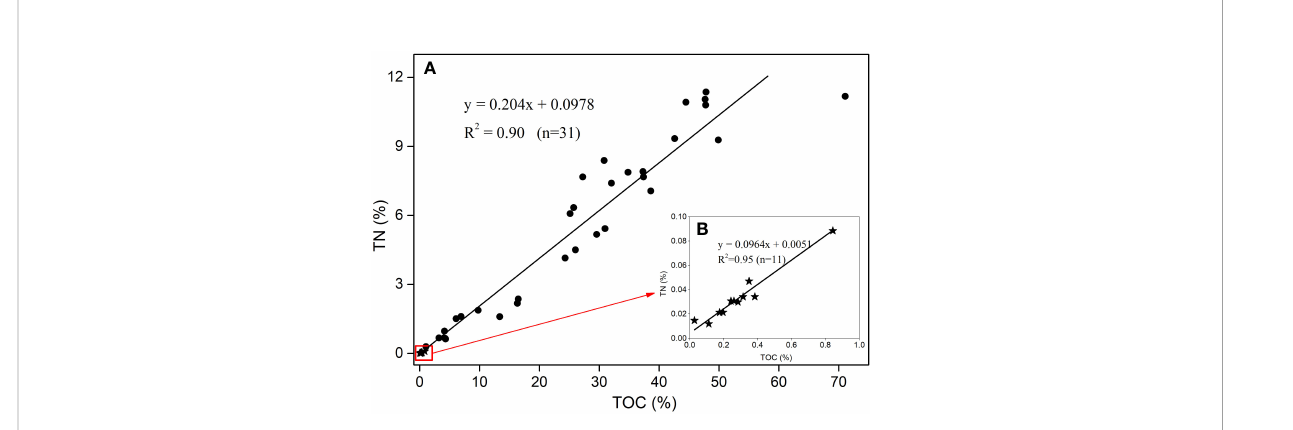
FIGURE 4 The differences between TOC and TN in the macrobenthos (black dots) and TOC and TN in sediments (black stars) from the NSCS. (A) Regression between TOC and TN in the macrobenthos; (B) regression between TOC and TN in sediments (after enlarging the red